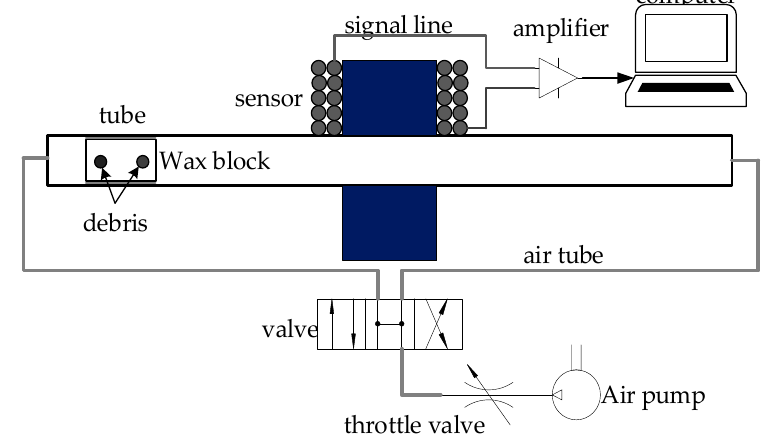
Figure 13. Wax block experimental system schematic.